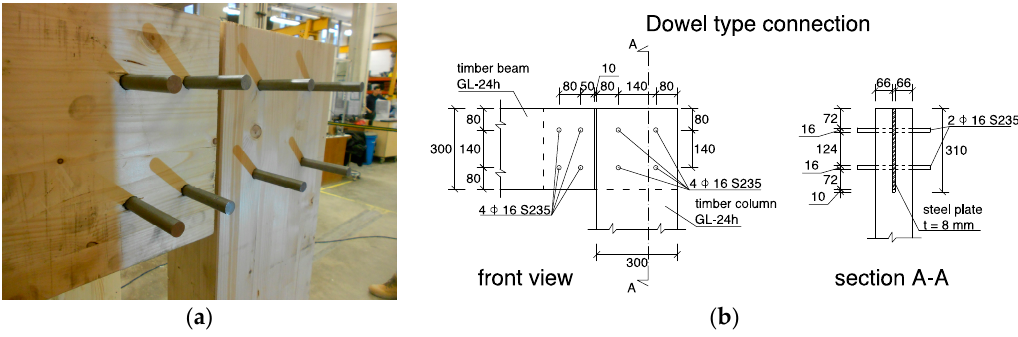
Figure 1. Dowel type connection: ( a ) beam-column joint; ( b ) joint layout (all lengths are in mm).